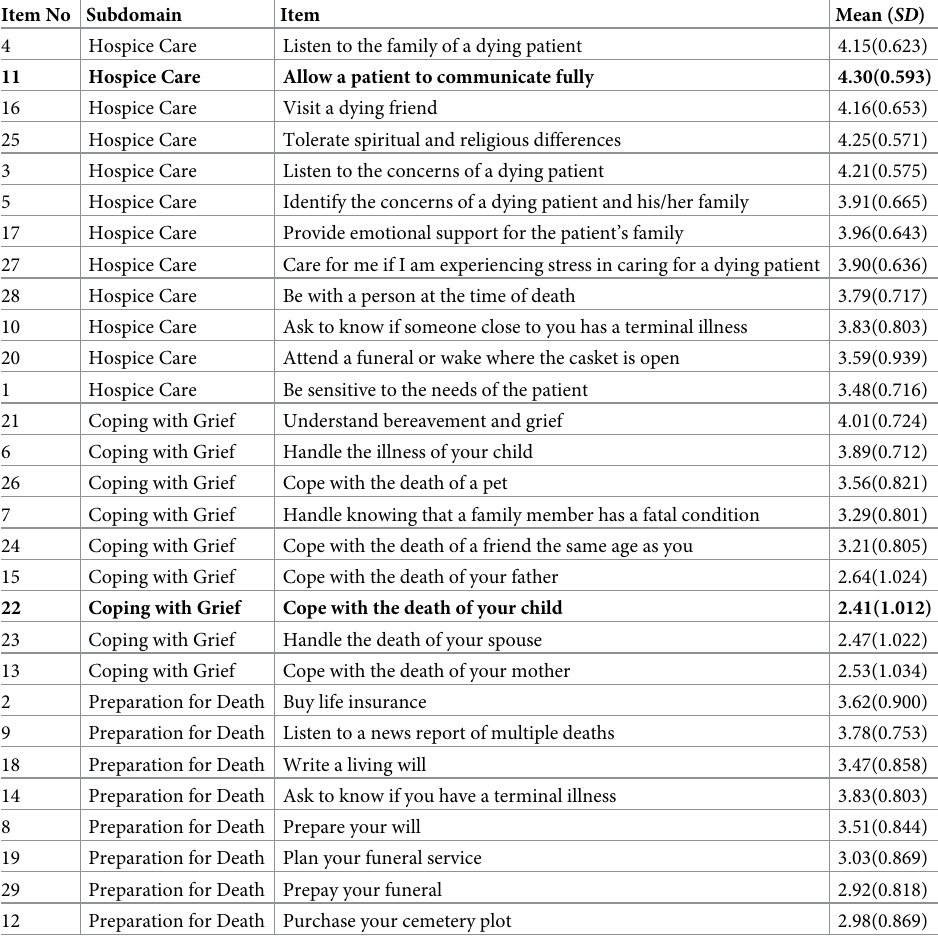
Table 3. Descriptive statistics of DCSS and its subscales, namely hospice care, coping with grief, preparation for death and other parameters. Item No Subdomain